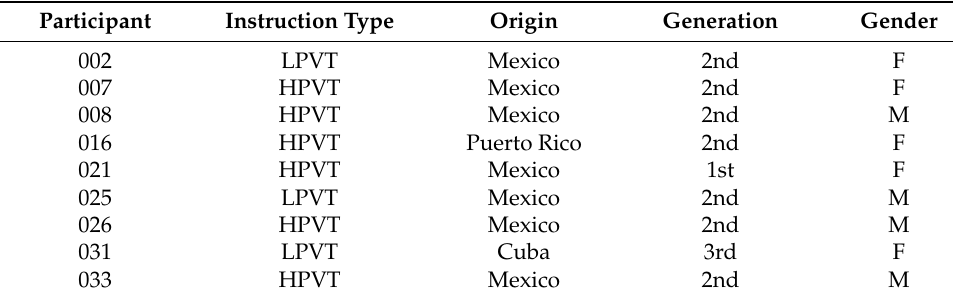
Table 1. Heritage speaker